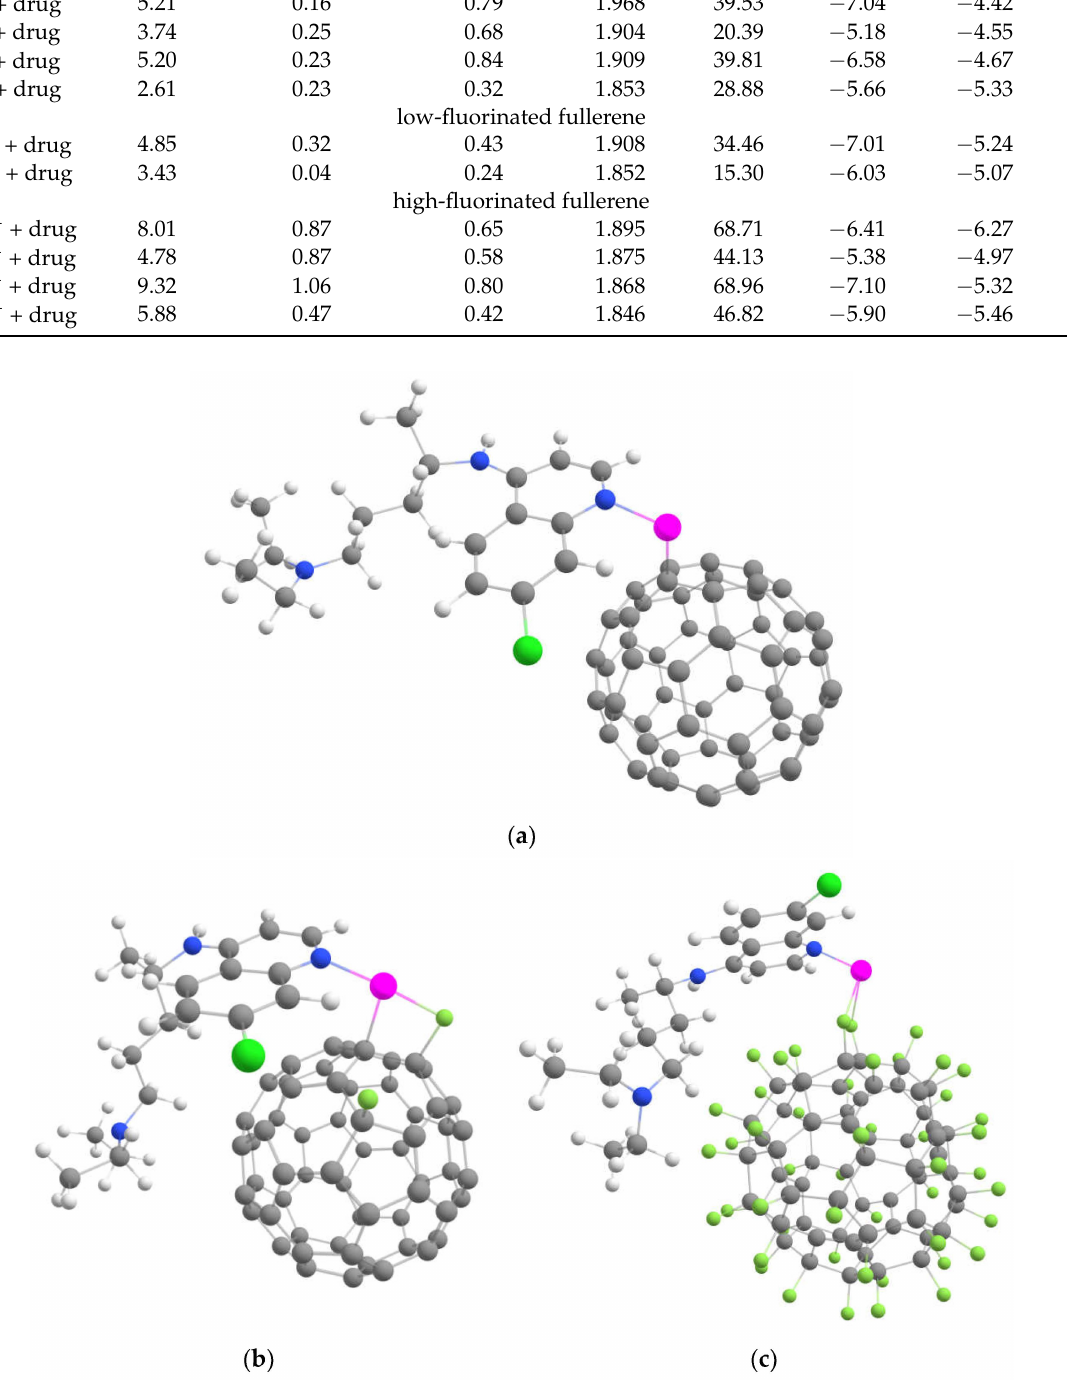
Figure 4. Optimized geometries of chloroquine drug loaded on Ni 2+ -decorated fluorinated fullerenes ( a ) C 60 Ni 2+ , ( b ) C 60 F 2 Ni 2+ and ( c ) C 60 F 48 Ni 2+